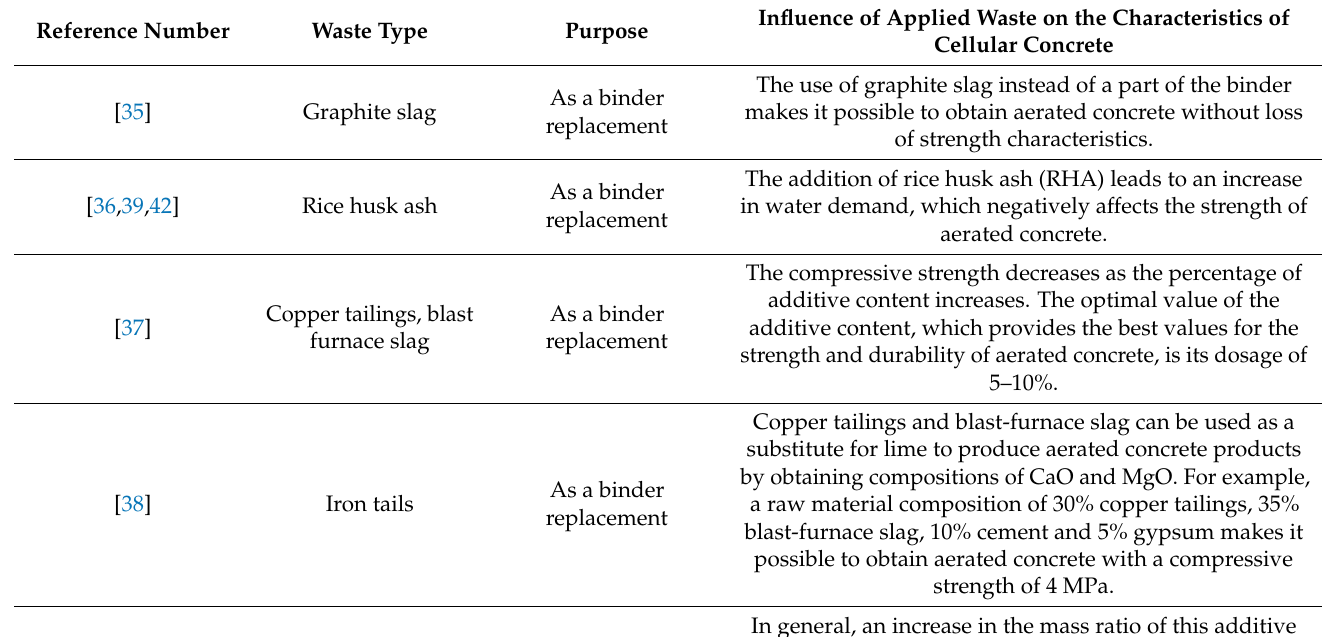
Table 1. Overview of the use of various types of waste in the technology of cellular